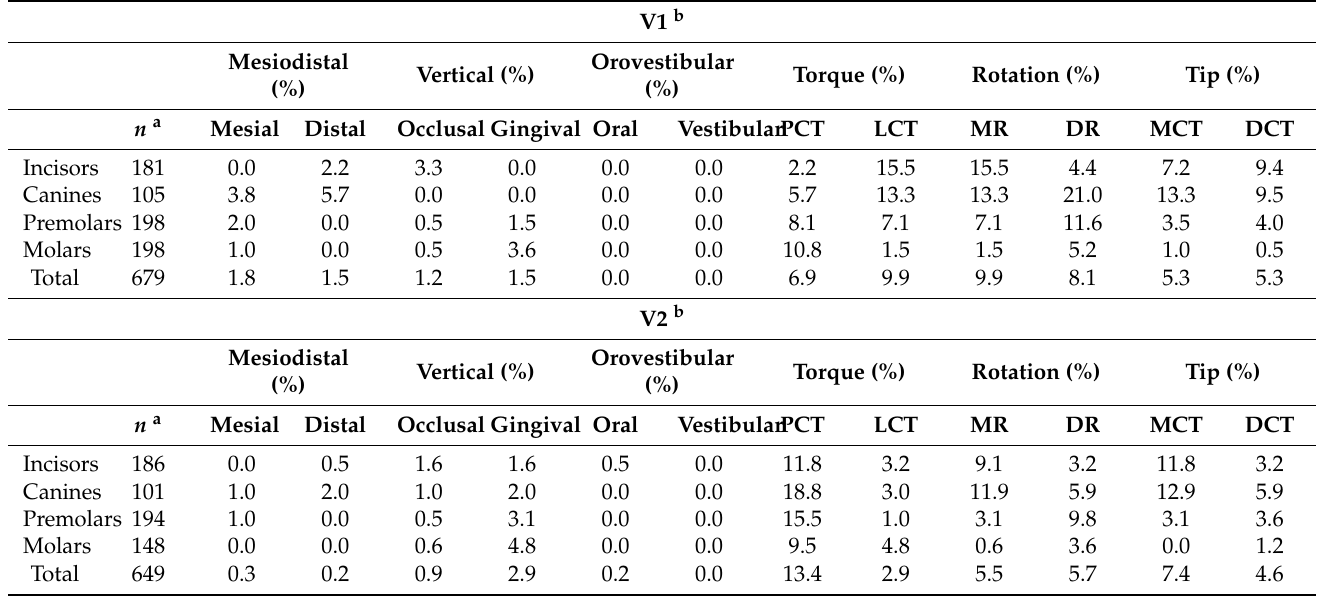
Table 2. Percentage of bracket positions outside the clinically acceptable transfer errors ( ± 0.2 mm and ± 1 ◦ ) for version 1 (V1) and version 2 (V2) according to the direction of deviation. V1 b